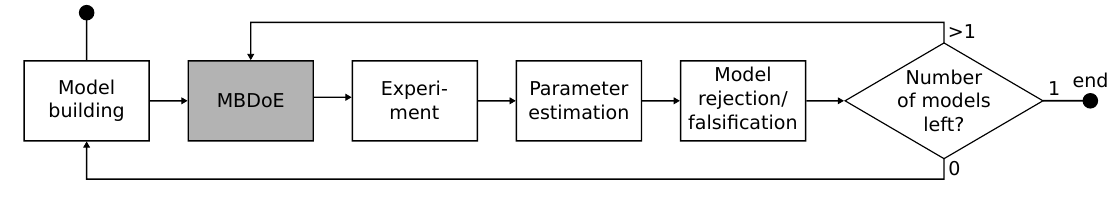
Figure 2. MBDoE workflow for model selection adapted from